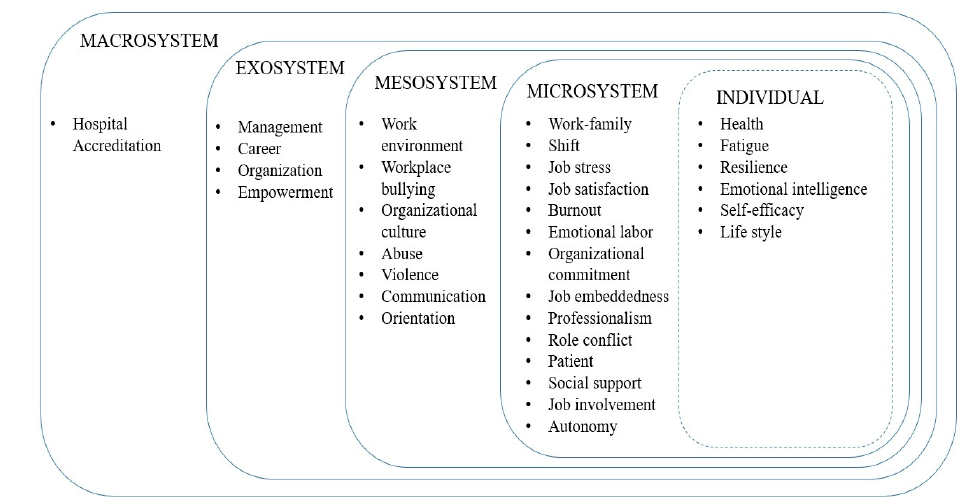
Figure 4. Classifications of the keywords by the Ecological Systems Theory.